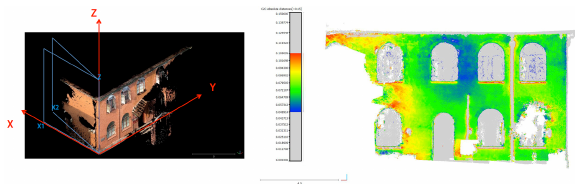
Figure 14. The deviation analysis of an inclined wall is partially meaningful due to the uncertainly of reference plane in XZ